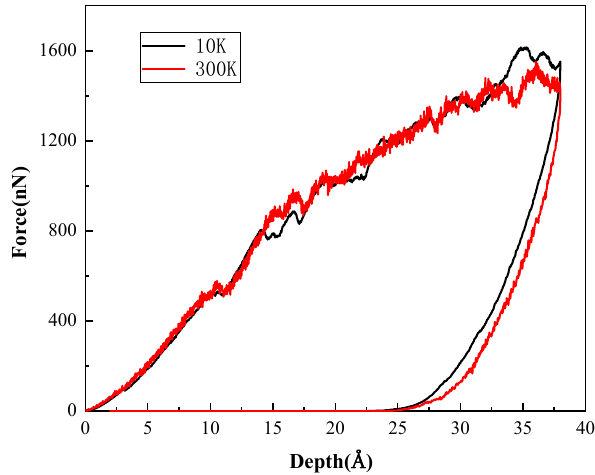
Figure 5. P - h curves at different temperatures.